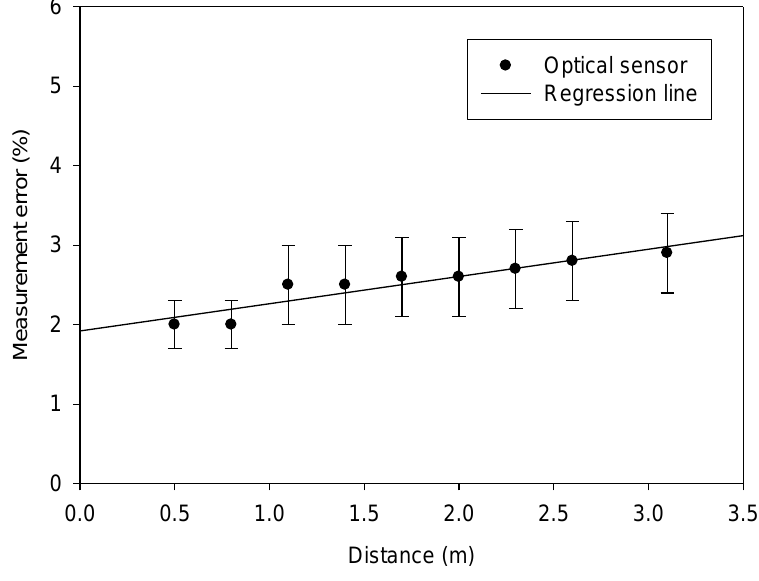
Figure 20. Measurement error of a WPWS equipped optical sensor.